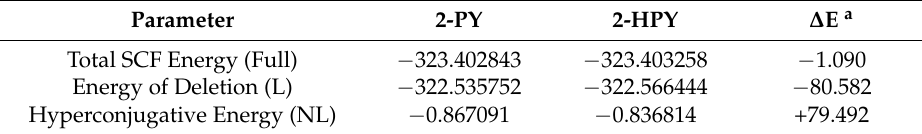
Table 6. Natural bond orbital (NBO) analyses of the total SCF, deletion and hyperconjugative energies